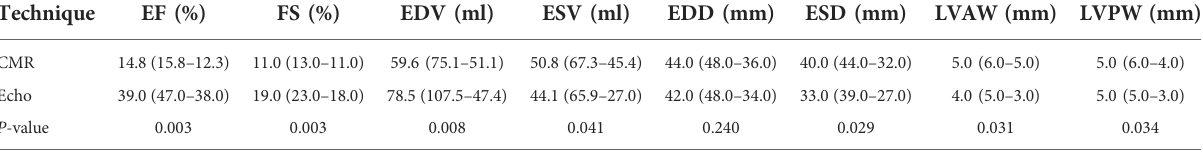
TABLE 4 LV parameters measured by CMR and Echo in patients with EFE. Technique